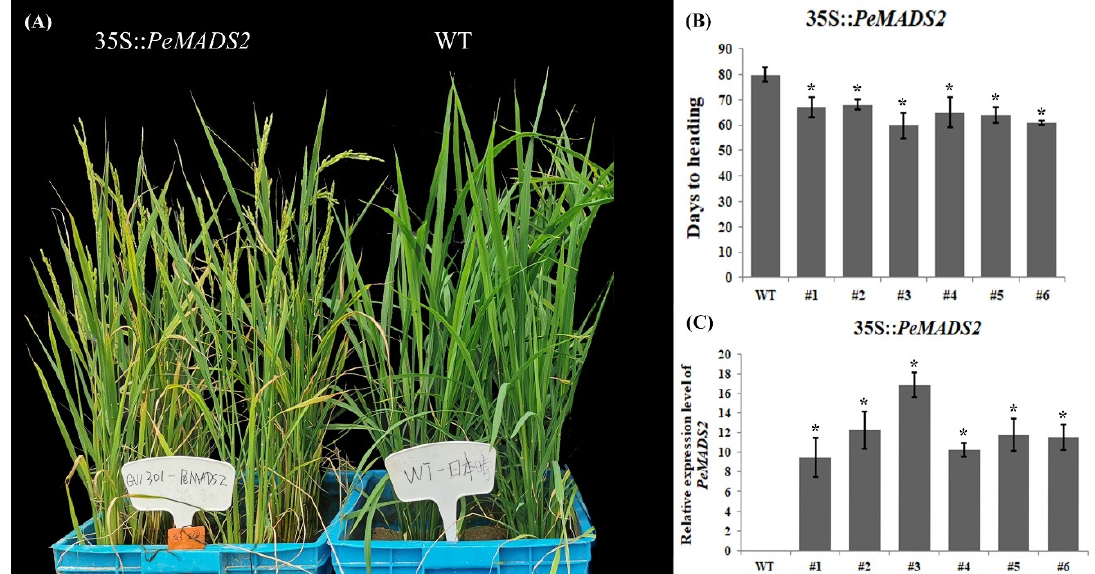
Figure 5. Ectopic expression of PeMADS2 in Oryza . ( A ) Representative picture of WT and ectopic expression lines of PeMADS2 after heading. ( B ) Days to the heading of T3 homozygous transgenic plants. ( C ) Relative expression levels of PeMADS2 in transgenic rice plants and WT. Asterisks indicate a significant difference between transgenic and WT plants (* p ≤ 0.05, t ’s test).